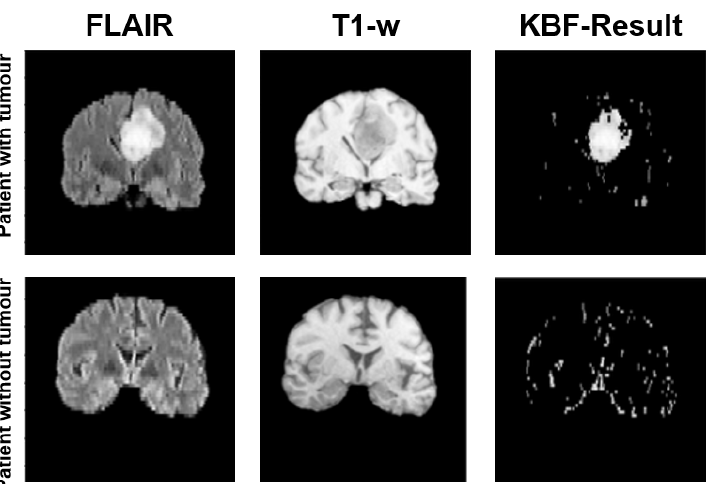
Figure 3. An illustrative example of the threshold operations performed during the KBF procedure on FLAIR and T1w slices (first image), reported in the first and second rows respectively. The red filter (second image) considers the mode value, while the third image represents the output of the first filtering process. On the other hand, the light-blue filter (fourth image) exploits the 25% of the highest and the 25% of the lowest values in the FLAIR and T1-w acquisition, respectively. The output of the KBF procedure is shown in the fifth image.